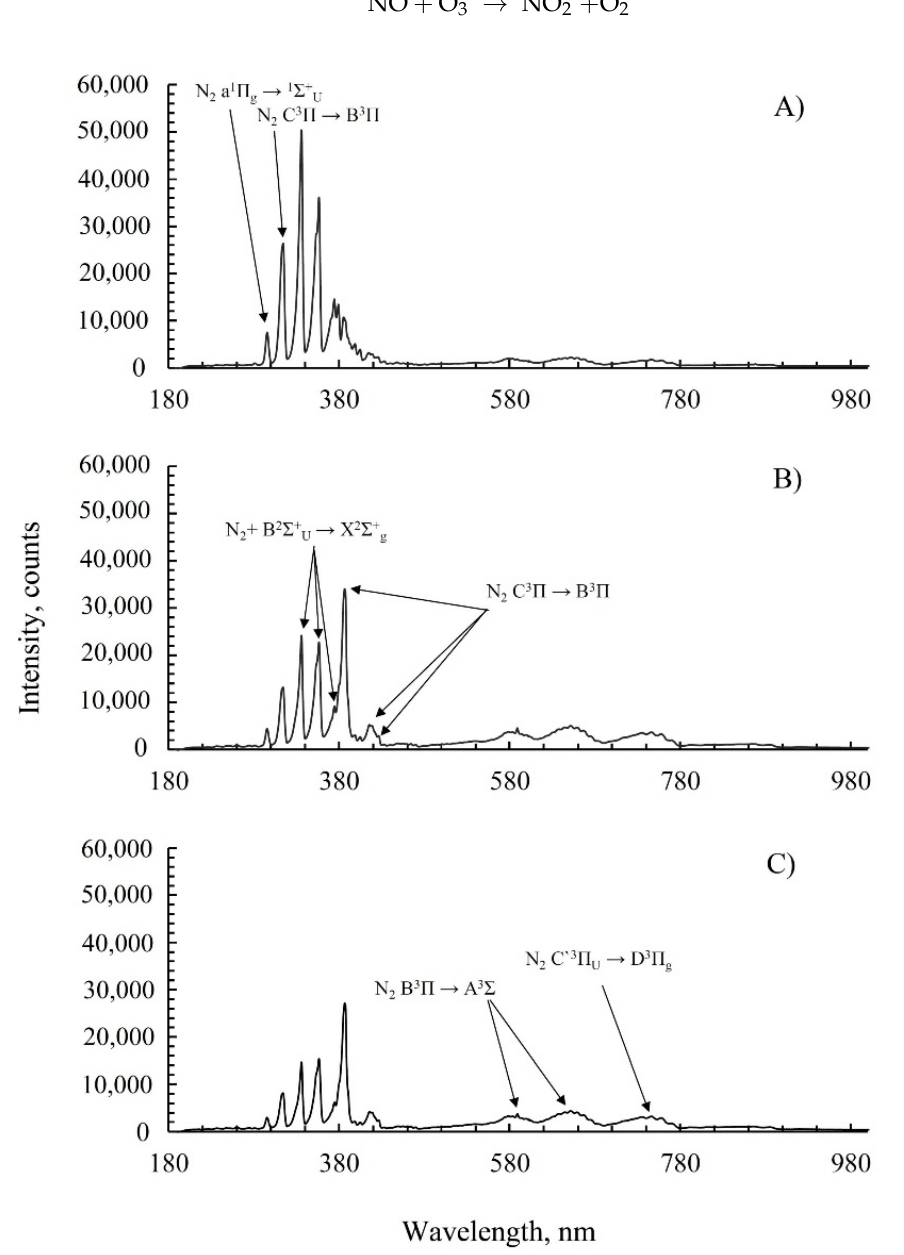
Figure 2. Emission spectrometry of nitrogen under different frequencies with the stable voltage U = 8300 V: ( A ) F = 60 kHz; ( B ) F = 180 kHz; ( C ) F = 220 kHz. Under these conditions, the reactions that are mostly going in the burner are (1) and (2), formatting exited atoms N( 2 D) and N( 2 P) as a result of molecule dissociation of the electron impact and, based on [26], almost completely converting themselves into NO. Because of the fact that effectiveness of (1) in version N 2 + e → N( 4 S) + N( 4 S) + e is low, and the oxidation pathway is mostly not possible; it could be assumed that, while concentrations of the N( 4 S) and NO can not differ dramatically, the further pathway is N( 4 S) + O 2 => NO + O and N( 4 S) + NO => N 2 + O, which guides to full disappearance of nitrogen particles and fractional decrease of NO concentration. Exited states of a nitrogen, N( 2 A) and N( 2 D), have much higher numbers of generated species through this